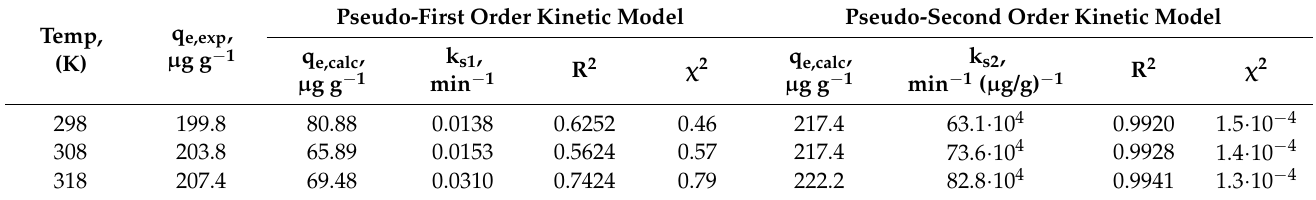
Figure 8. Pseudo-second-order kinetic model for As(V) adsorption onto functionalized materials ( a ) V-DEHPA-Fe and ( b ) VF-DEHPA-Fe, at different temperatures. Table 1. Kinetic parameters for the adsorption of As(V) onto material V-DEHPA-Fe.